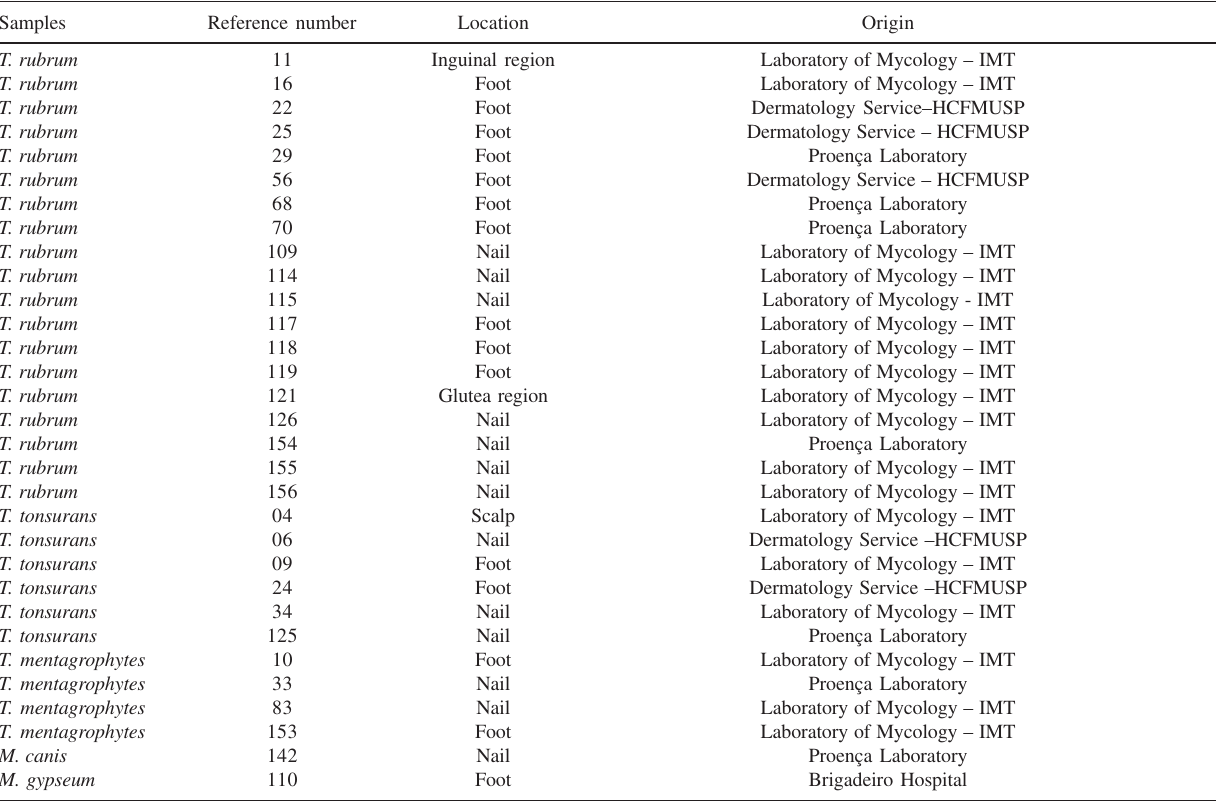
Table 1 – Dermatophyte identification of 31 clinical samples studied